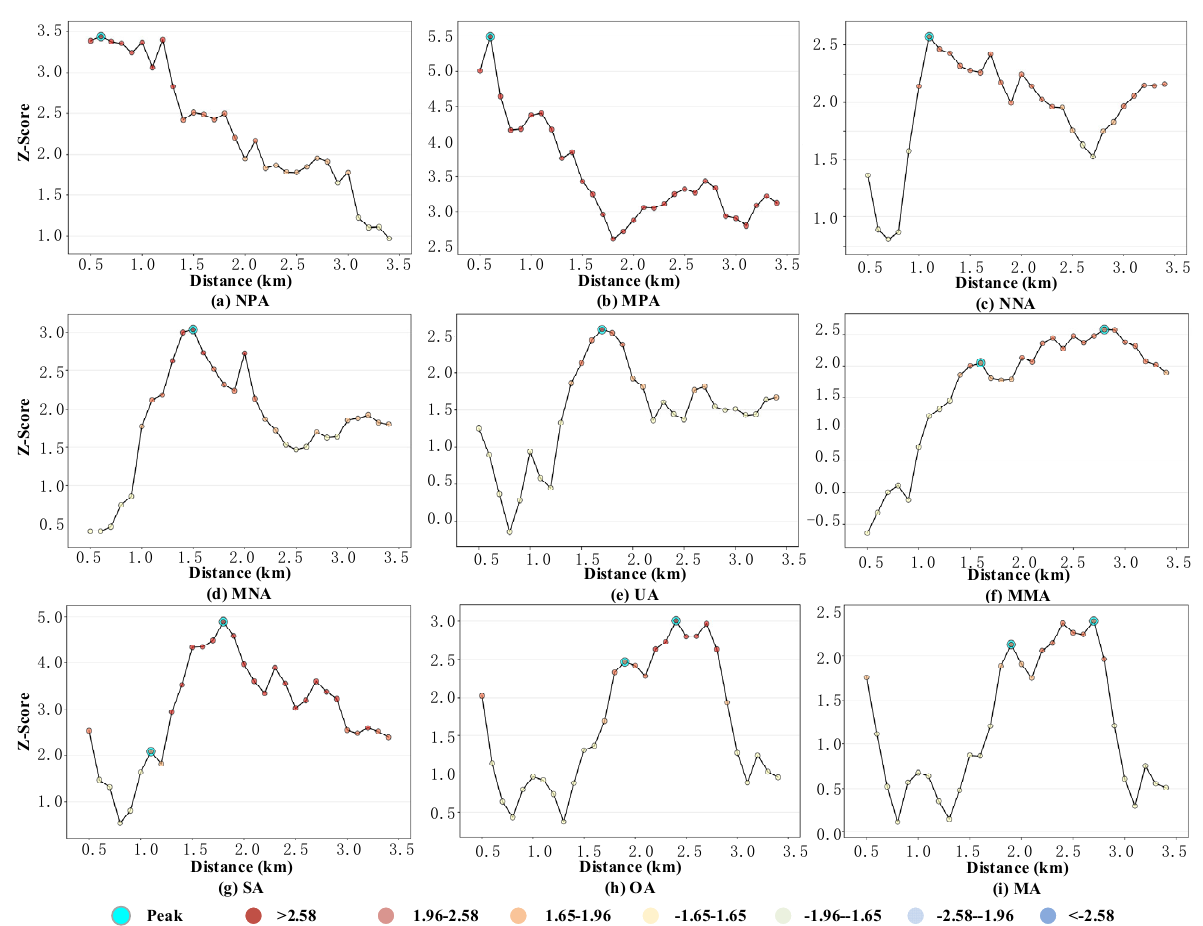
Figure 3. The results of incremental spatial autocorrelation for different types of accidents. Figure 3 shows the relationships of scale distances and z ‐ scores for each type of accident. The evidence that at least one peak point exists on the curve for each type of accident means that it is reasonable to fix the analysis range between 0.5 km and 3.5 km. When classifying accidents by participants, as seen in Figure 3a–f, the optimal scale distance varies from 0.6 km to 2.8 km, with a mean value of 1.38 km. When classifying accidents by severity, as seen in Figure 3g–i, the optimal scale distance varies from 1.8 km to 2.7 km, with a mean value of 2.3 km. These results show that the optimal scale range is different for different types of accidents. Another interesting finding is that the optimal scalar distance is positively correlated with the distance of resident travel modes. For example, for accidents involving pedestrians, that is, NPA and MPA, the distance corresponding to the highest z ‐ score is 0.6 km. This distance is obviously significantly smaller than the mean value of the same category (i.e., 0.6 < 1.38) and is strongly correlated with the travel dis ‐ tance of walking. Another possible reason may be that accidents involving pedestrians are often concentrated at intersections. Similarly, the optimal scalar distance increases signif ‐ icantly with the involvement of motor vehicles, namely 1.1 km (NNA) < 1.5 km (MNA) < 2.8 km (MMA), due to the fact that the distance travelled by a car is much longer than by walking or cycling. This means that if a suitable distance parameter is to be chosen for traffic accident analysis, the accident type should be fully considered. The ideal scalar distance varies with the type of accident and is influenced by the distance of the travel mode. Simply taking the entire accident dataset as the model input without considering the classification may result in unreasonable distance bands, which further leads to insig ‐ nificant feature identification or the loss of data continuity.